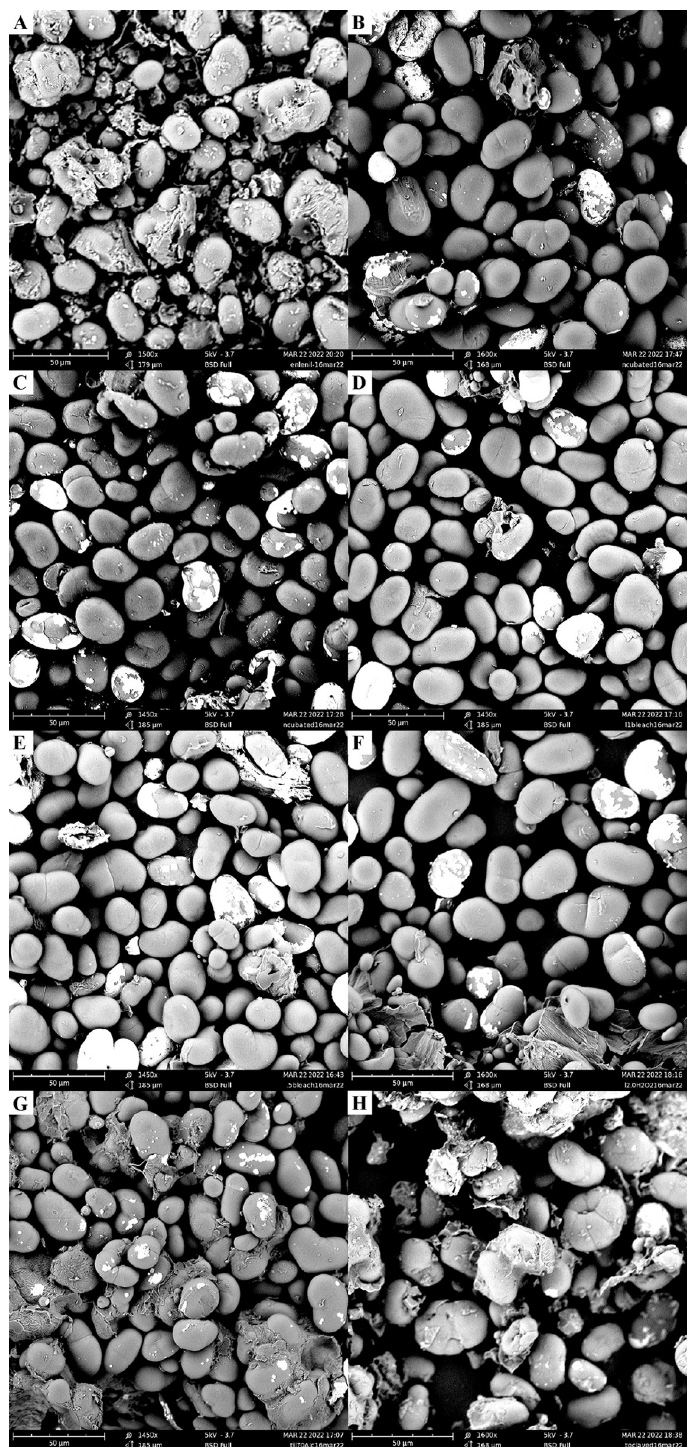
Fig 9. Scanning electron microscopy images of treated and untreated green lentil pulse flours at 50 μ m scale. Treatments: (A) untreated control, not washed and not chemically treated (B) DI water washed 10 times and immediately dried, not incubated; (C) DI water incubated, then DI water washed 10 times and immediately dried; (D) Treated with bleach (1.0%) incubated, then DI water washed 10 times and immediately dried; (E) Treated with bleach (1.5%) incubated, then DI water washed 10 times and immediately dried; (F) Treated with hydrogen peroxide (2.0%)